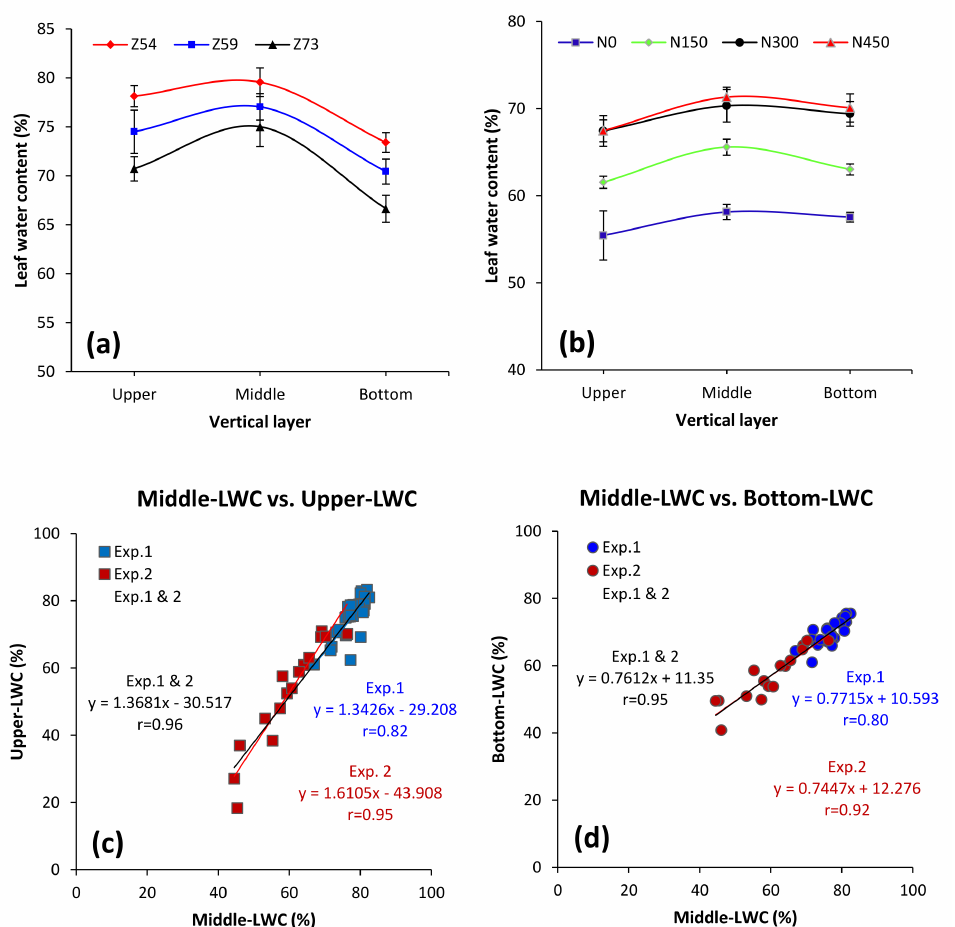
Figure 3. Vertical profiles of LWC within wheat canopies ( a ) at different growth stages; ( b ) under different N treatments at the head emergence stage (Z54), error bars represent standard deviation of vertical LWC measurements; the relationships between ( c ) the middle-LWC vs. the upper-LWC and ( d ) the middle-LWC vs. the bottom-LWC for both